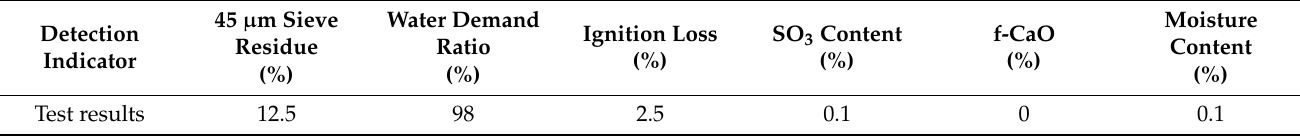
Table A4. Physical and chemical properties of